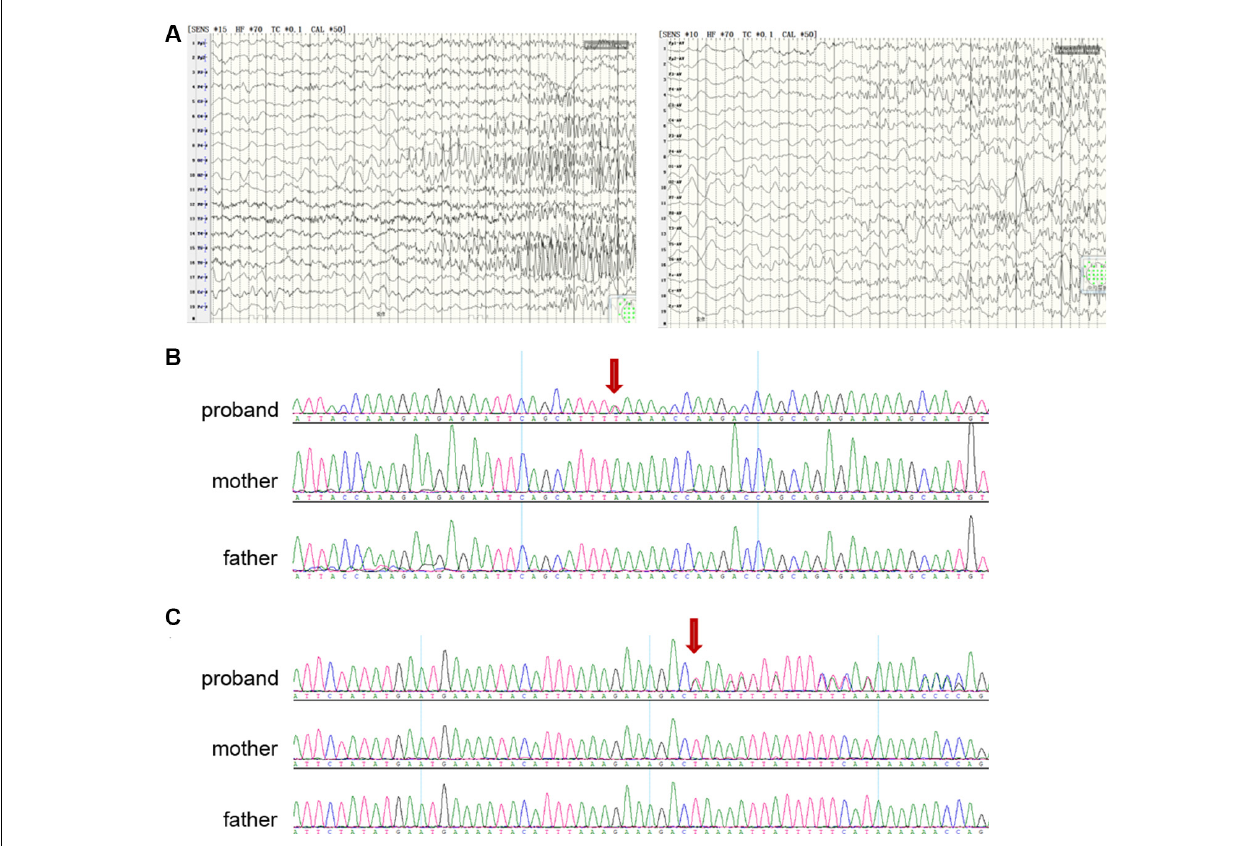
FIGURE 2 | Clinical and genetic data. (A) Electroencephalographic (EEG) of a proband with epilepsy of infancy with migrating focal seizures (EIMFS; patient A), showing seizures arising from different hemispheres (left: left occipital lobe; right: right frontal lobe). (B) Sanger sequencing showing (red arrow) nonsense variant p.K564 ∗ (NM_198503.2:c.1690A > T) in KCNT2 in the proband (patient A) and not in the parents. (C) Sanger sequencing showing (red arrow) frameshift variant p.L48Qfs43 (NM_198503.2:c.143-144 delTA) in KCNT2 in the proband (patient B) and not in the